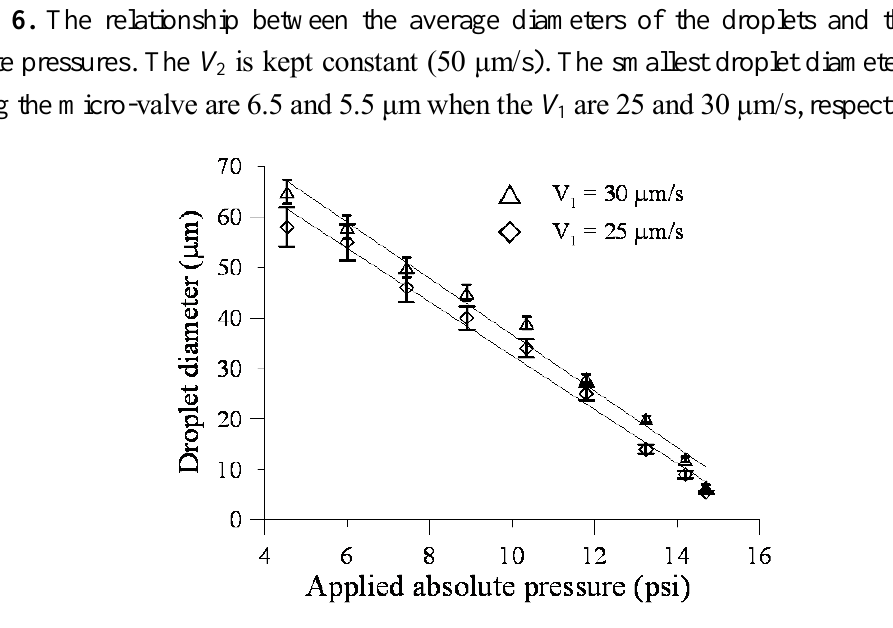
Figure 6. The relationship between the average diameters of the droplets and the applied absolute pressures. The V is kept constant (50 μm/s). The smallest droplet diameters 2